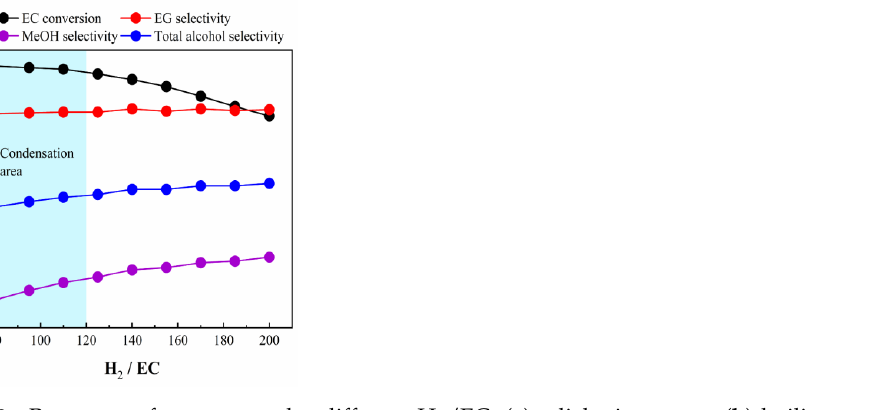
Figure 8. Reactor performance under different H 2 /EC: ( a ) adiabatic reactor, ( b ) boiling water-cooled reactor, ( c ) conduction oil-cooled reactor. Operating conditions: reactant and coolant inlet tempera- tures 463 K, 3 MPa, 0.3 g EC ·gcat − 1 ·h − 1 , 80 – 200 H 2 /EC. temperatures 463 K, 3 MPa, 0.3 g EC · gcat − 1 · h − 1 , 80–200 H 2 /EC.